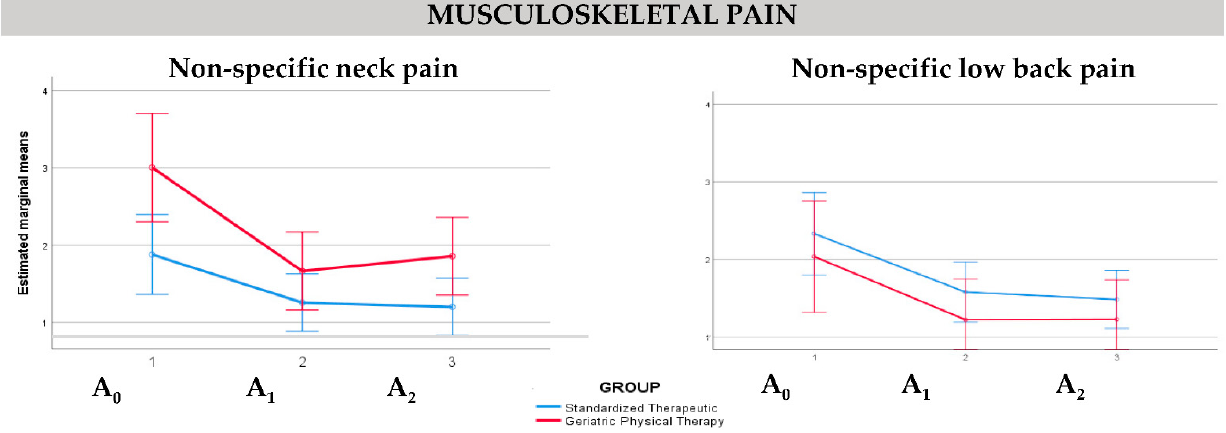
Figure 3. Estimated marginal means of musculoskeletal pain at baseline (A 0 ), post-intervention (A 1 ), and final (A 2 ) assessments by intervention